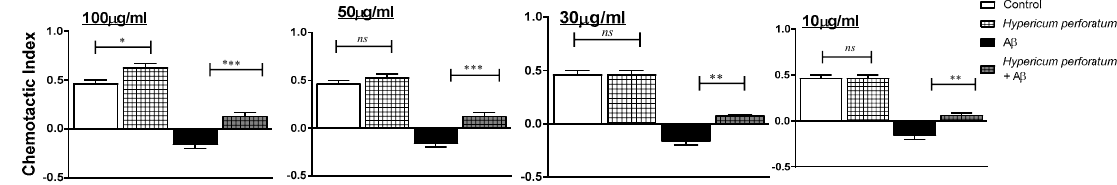
Figure 4. Concentration-dependent effects of plant extracts on chemotactic index (CI) in Globodera pallida . G. pallida were pre-incubated (24 h) with either: vehicle control (1% DMSO in ddH 2 O), A β (1-42) at 100 µ M, plant extract (10–100 µ g/mL) alone, or in combination with A β (1-42). Data are mean ± SEM ( n = 3) with approximately 100 G. pallida organisms per observation. * p < 0.05, ** p < 0.01, and *** p < 0.001 (significant) and ns (not significant) for the comparisons are indicated.